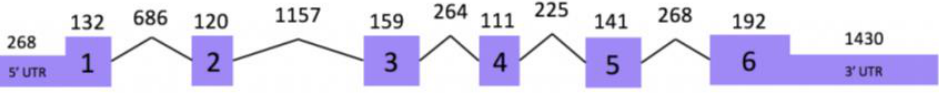
Figure 1. Structure of the S. aurata myomaker gene. The size of exons including the UTRs (purple boxes) and introns (lines) are indicated in the number of nucleotides.